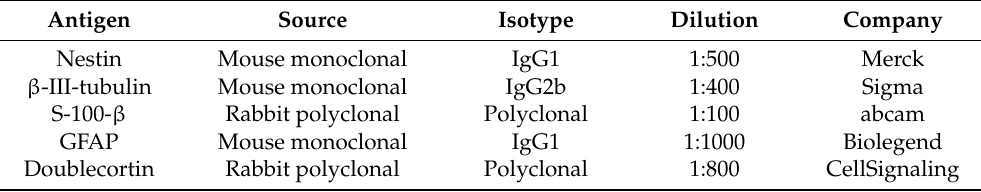
Table 3. List of primary antibodies used for